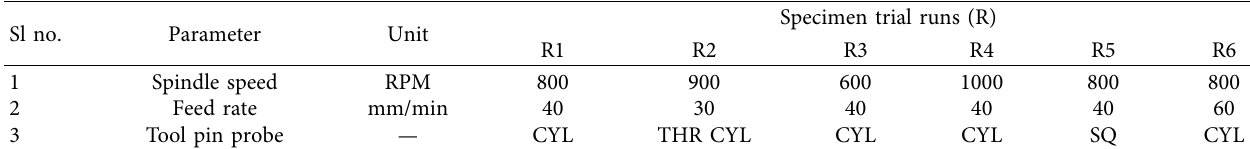
Table 5: Operating parameters for welding.